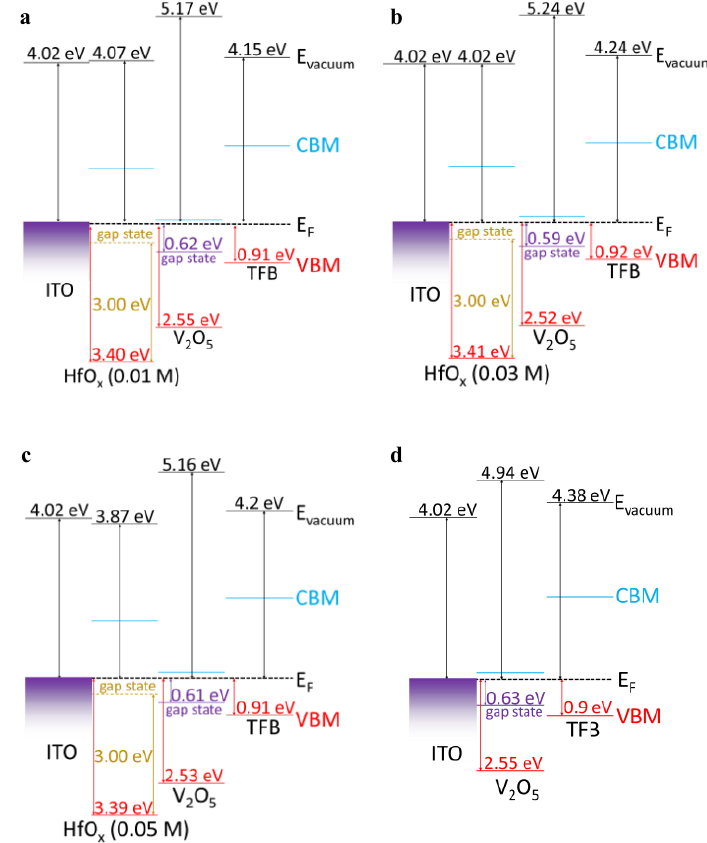
Figure 5. Schematic energy level diagram of QLEDs ( a ) without the HfO x layer, and with the ( b ) HfO x (0.01 M), ( c ) HfO x (0.03 M), and ( d ) HfO x (0.05 M) layer.